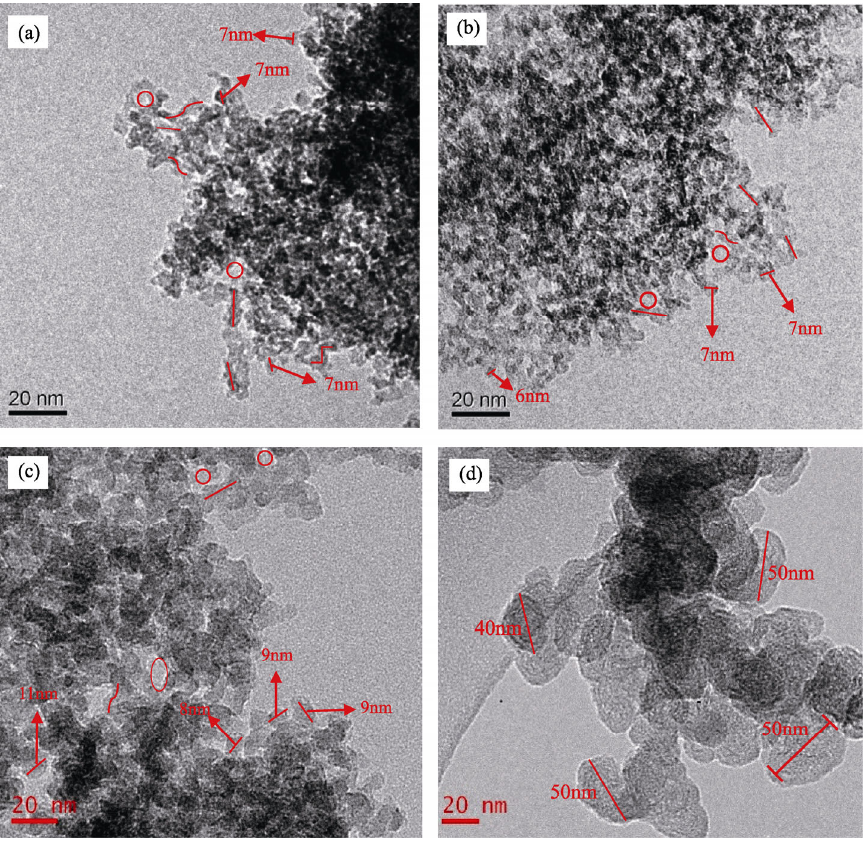
Fig. 8 TEM images of SiO 2 aerogels calcined at different temperatures: (a) room temperature; (b) 600 ℃ , 2 h; (c) 800 ℃ , 2 h; (d) 1000 ℃ , 2 h; symbols of circle stand for pores and line for